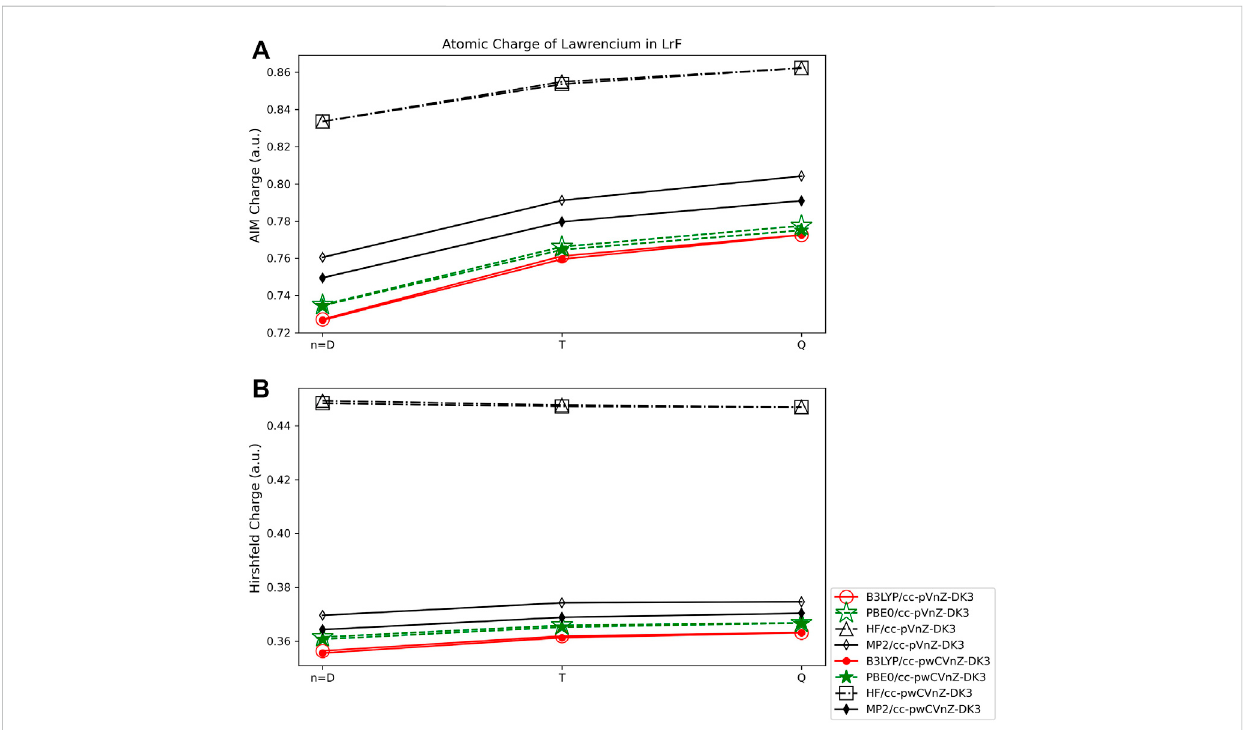
FIGURE 11 Atomic charge of lawrencium in LrF determined using a number of theoretical methods, Dunning style basis sets, and population analysis methods: (A) AIM, and (B) Hirshfeld (*Note that scales vary from one analysis method to another.).